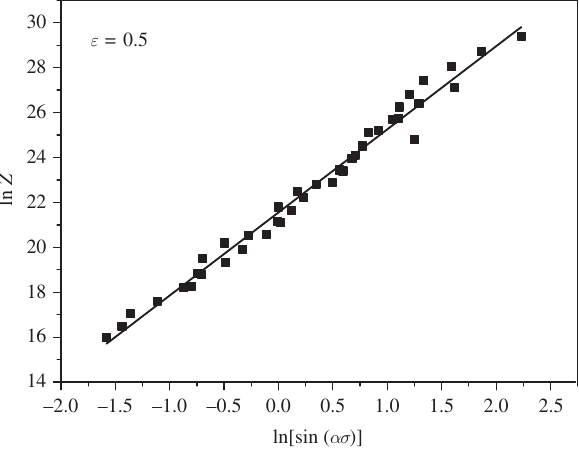
Figure 13 Variation of the Z parameter with flow stress (at strain of